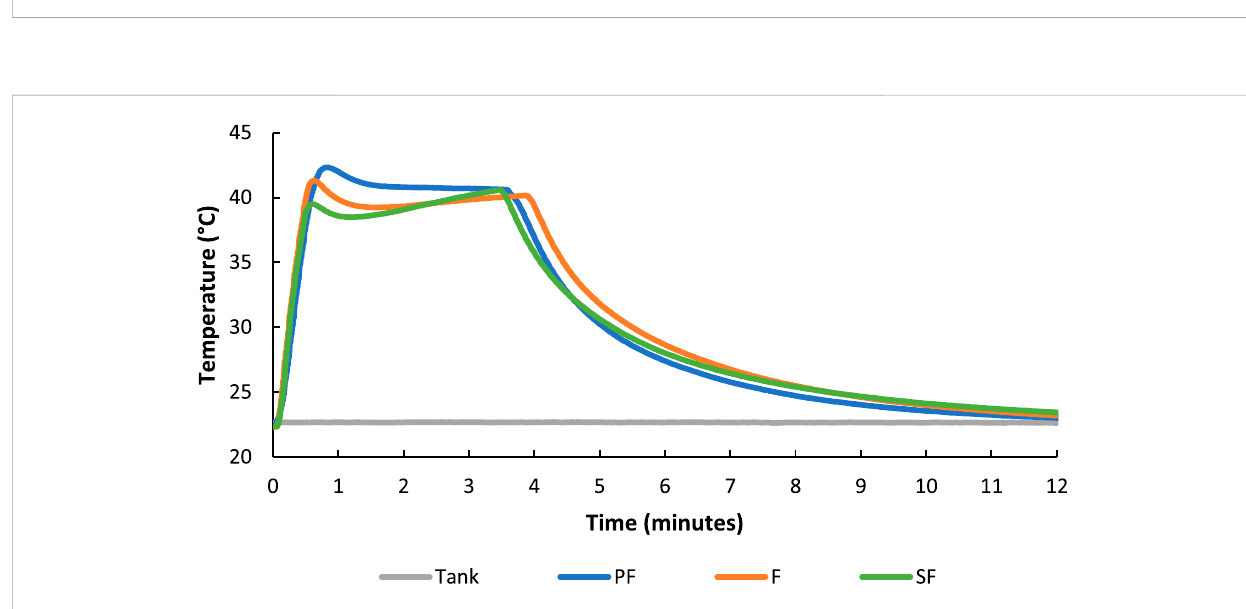
FIGURE 10 FUS heating of PEG- fi brinogen (PF), PEG- fi brinogen with fi brin microparticles (F), and PEG- fi brinogen with SNAP- fi brin microparticles(SF) hydrogel formulations showed no differences in heating